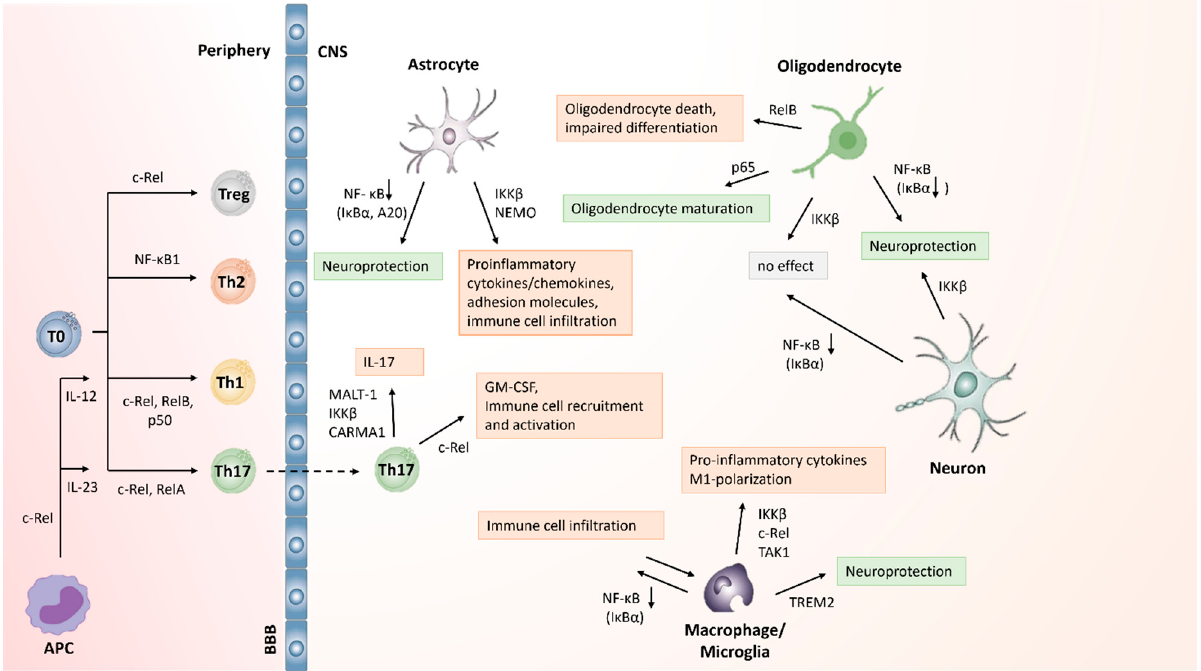
Figure 5. Cell-type specific role of NF- κ B signaling in MS and EAE . Elements from this figure were adapted from [87,182]. This figure was generated with BioRender.